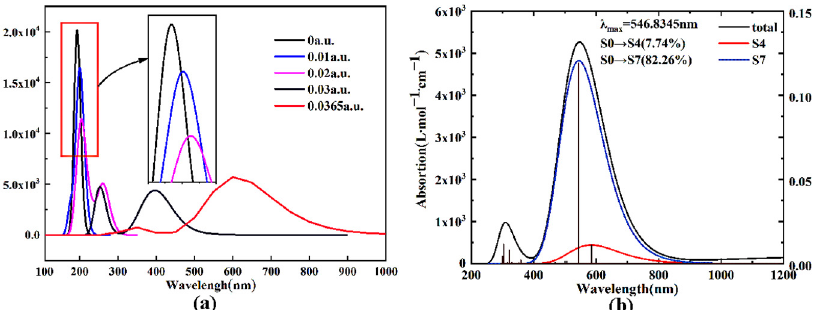
Figure 9. Modulation effect of external electric fields on the absorption spectrum of B 9 N 9 ; ( a ) the total absorption spectrum curve; ( b ) the contribution curves from the electronic excitations with vibrational intensity greater than 0.01.